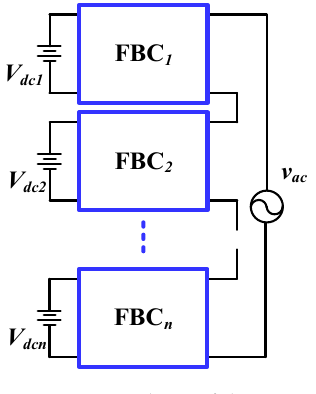
Figure 1. Topology of the CC.